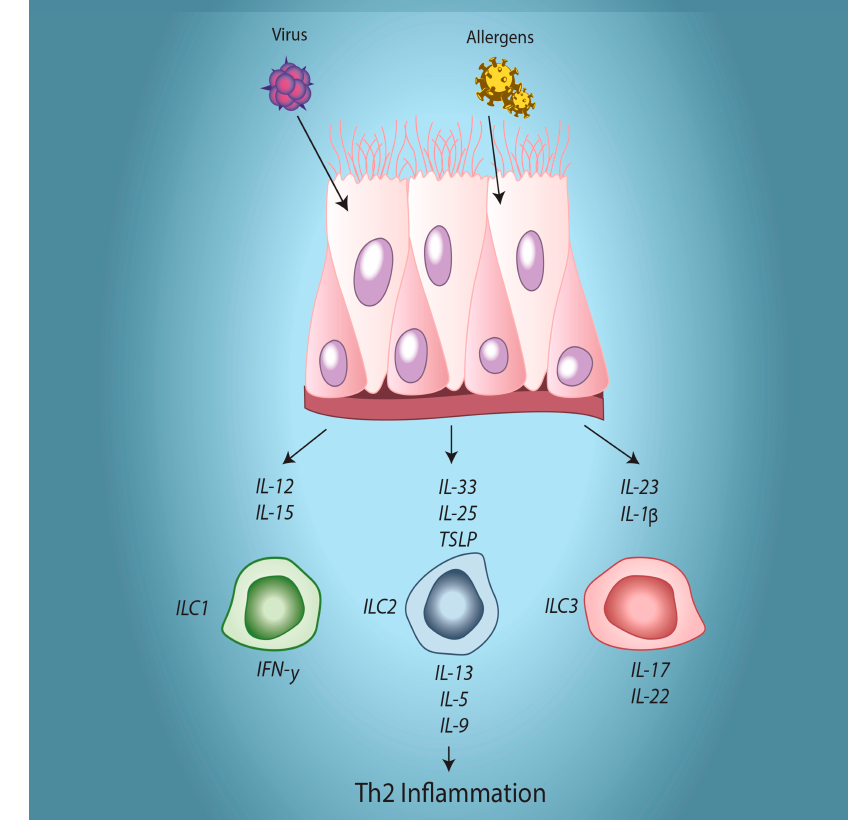
Figure 2. Human rhinovirus (HRV) infection and allergic stimulation can both induce epithelial production of IL-33, IL-25, and thymic stromal lymphopoietin (TSLP) that will stimulate activation of ILC2 cells to drive Th2 inflammation.